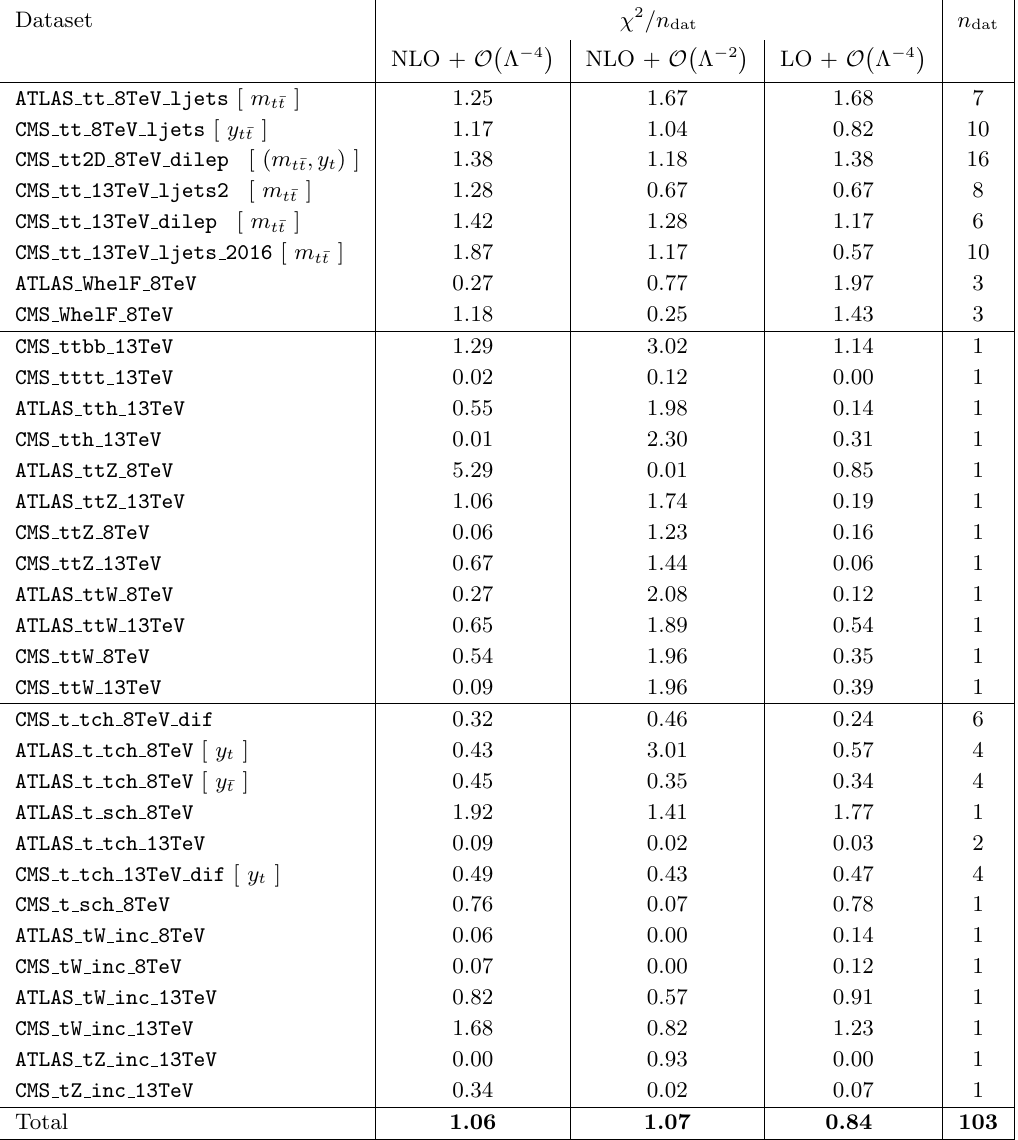
Table 11 . Same as table 7, now comparing the (cid:31) 2 =n theory settings (NLO QCD and (cid:12)ts where either only LO QCD e(cid:11)ects or